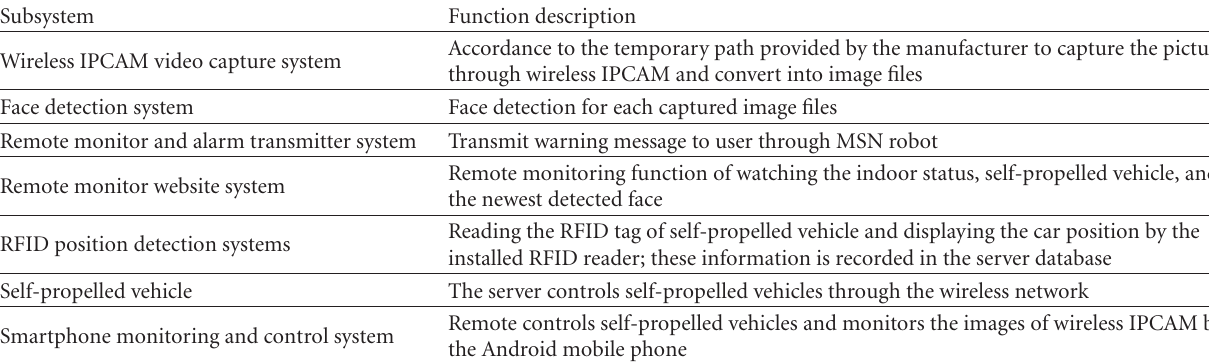
Figure 11: Display result of local wireless IPCAM (left: front; right: rear). Table 1: Subsystem functional